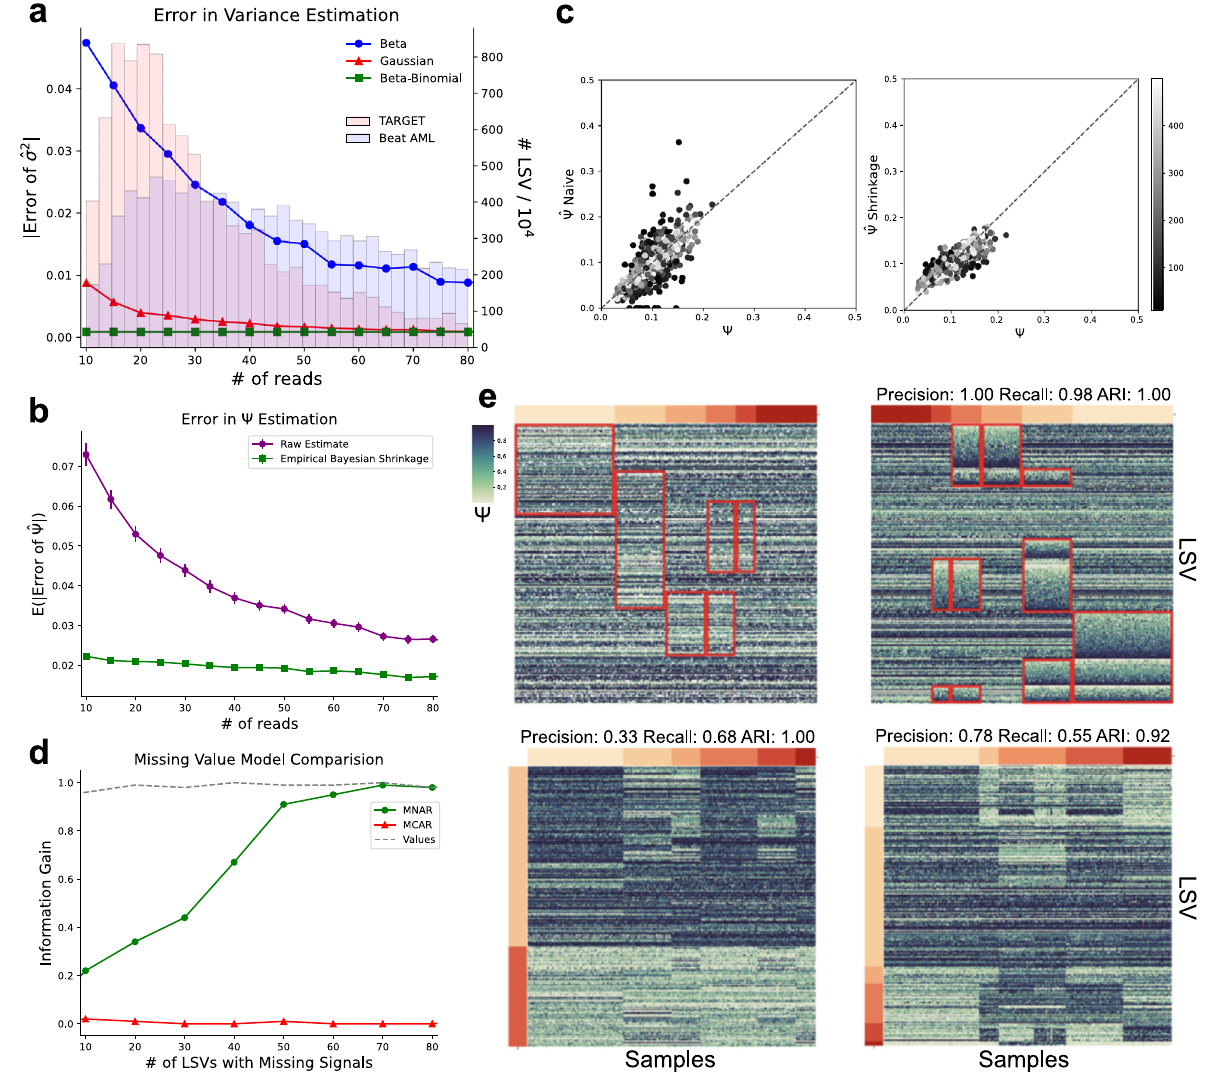
Fig. 2 | Model Evaluation. a Error in Ψ variance estimation under Gaussian (red), Beta (blue), and Beta-Binomial (green) models as a function of LSV coverage ( x - axis). Absolute error in Ψ variance estimates ( y -axis) is compared to the true var- iance, assuming a Beta(10,90) distribution. Inset histograms show empirical dis- tributions of LSV coverage in beatAML and TARGET data. b Error in ^ Ψ quanti fi cationestimatesunderanaiveandempiricalshrinkagemodelasafunction ofreadcoverage( x -axis,1000samplesfromthesameBetaasaboveforeachpoint). Naiveapproachusesonlyreadratiostoestimate ^ Ψ whileshrinkagemodelusesthe expectation over the posterior for the Beta. Error bars represent the 90% con- fi denceintervalfortheerrorin Ψ . c Correlationbetween Ψ and ^ Ψ estimatesundera naive (left) and empirical shrinkage model (right). Ψ was sampled as in ( a ) while number of reads n represented by the grey scale was sampled randomly from [10,500]. d Information gained (Supplementary Note 2.2) from missing signals. Hereabackgroundmatrixwasused,consistingof100samplesand100LSVswitha fi xedmissingness rate of 10%, into which a signaltile was implanted. The signaltile